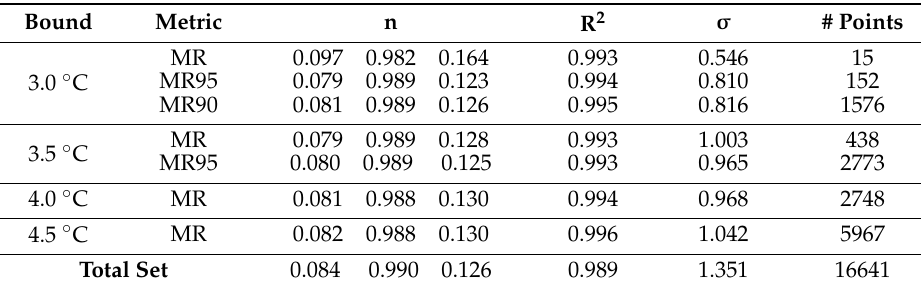
Table 2. Best fit line statistics for MR method.